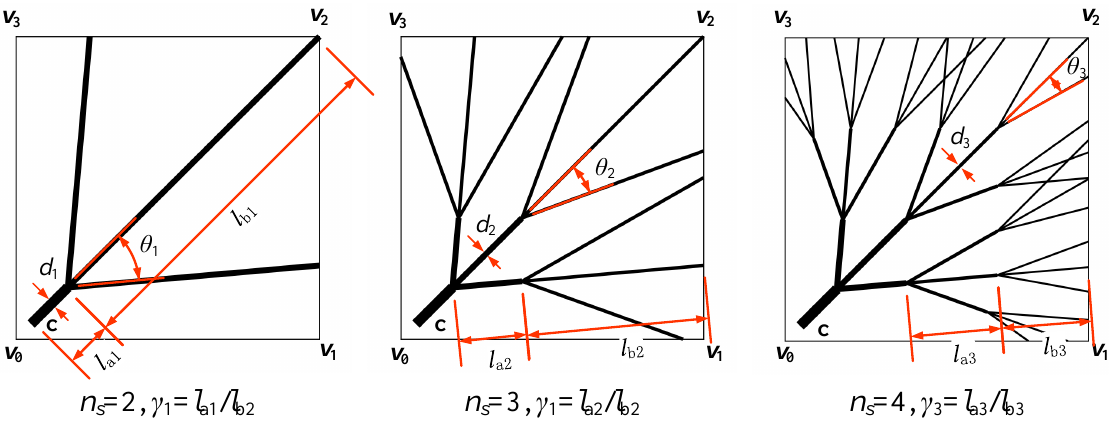
Figure 5. Parametric model describing the growth features of leaf vein. When the above main parameters vary, the model also changes accordingly, for instance, when n s , Θ and Γ take different values, the generated models are shown in Figure 6.